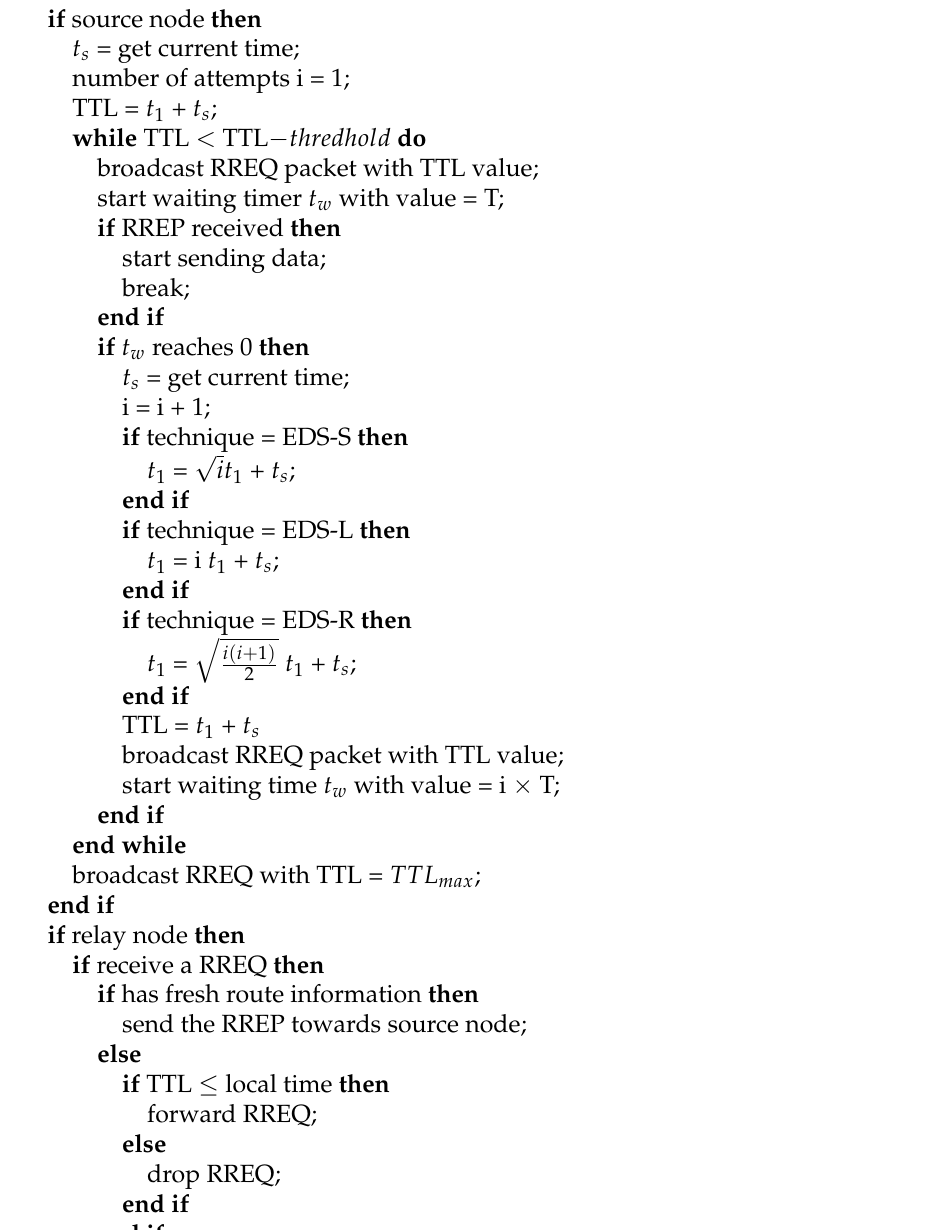
Algorithm 1 Pseudocode for